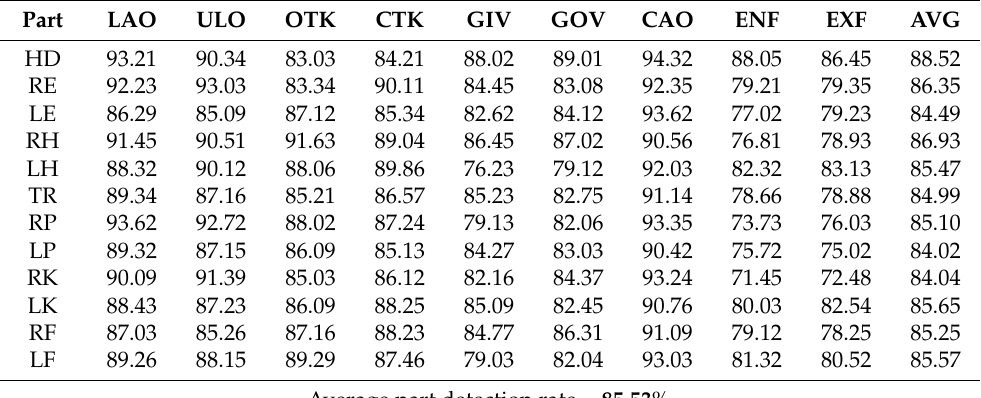
Table 4. Results of body part detection over the VIRAT Video dataset.